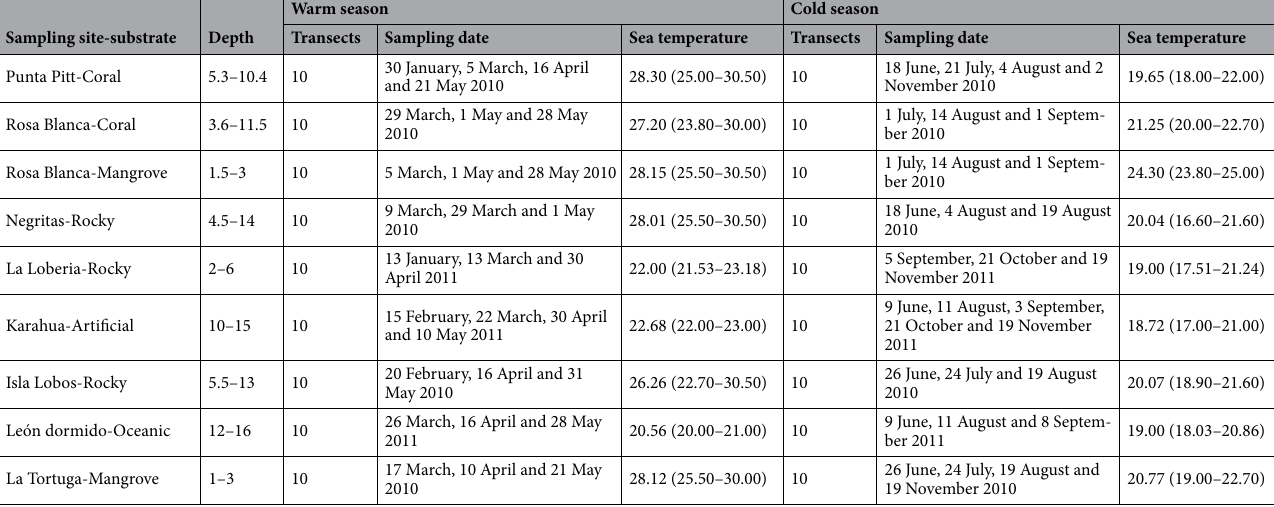
Table 1. Samplings conducted at study sites during the warm and cold seasons. Dives depth (m) minimum and maximum values, number of transects surveyed, sampling dates, and sea temperature (°C) mean values (minimum and maximum in parenthesis) recorded per season and